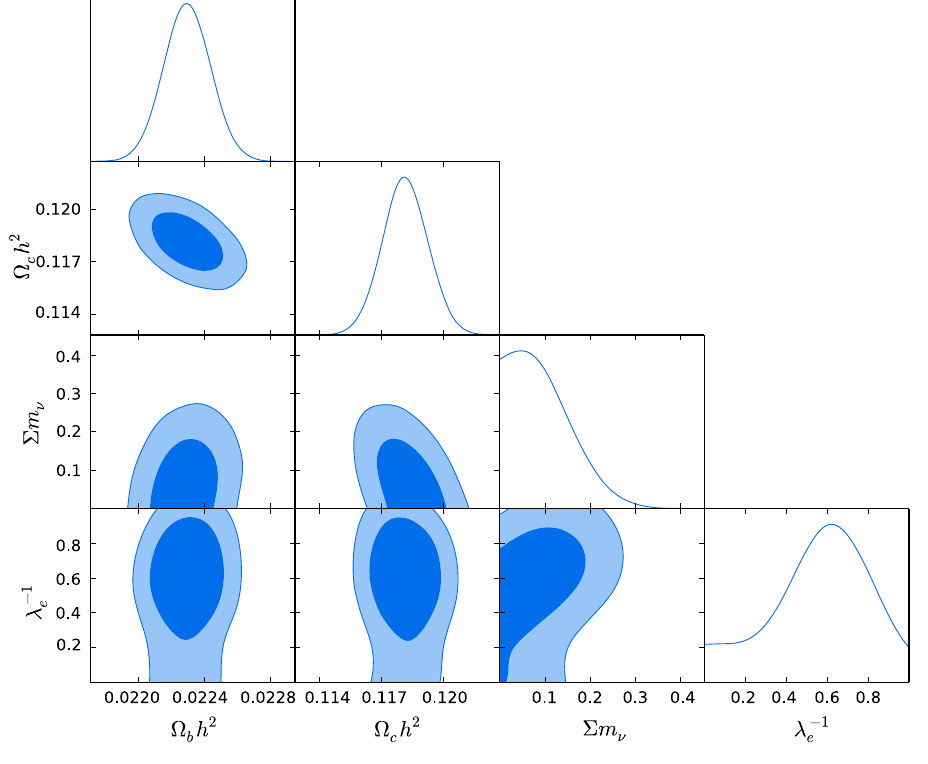
contour plots of (cid:9) b , (cid:9) c , (cid:16) m ν and λ − 1 e in the exponential gravity